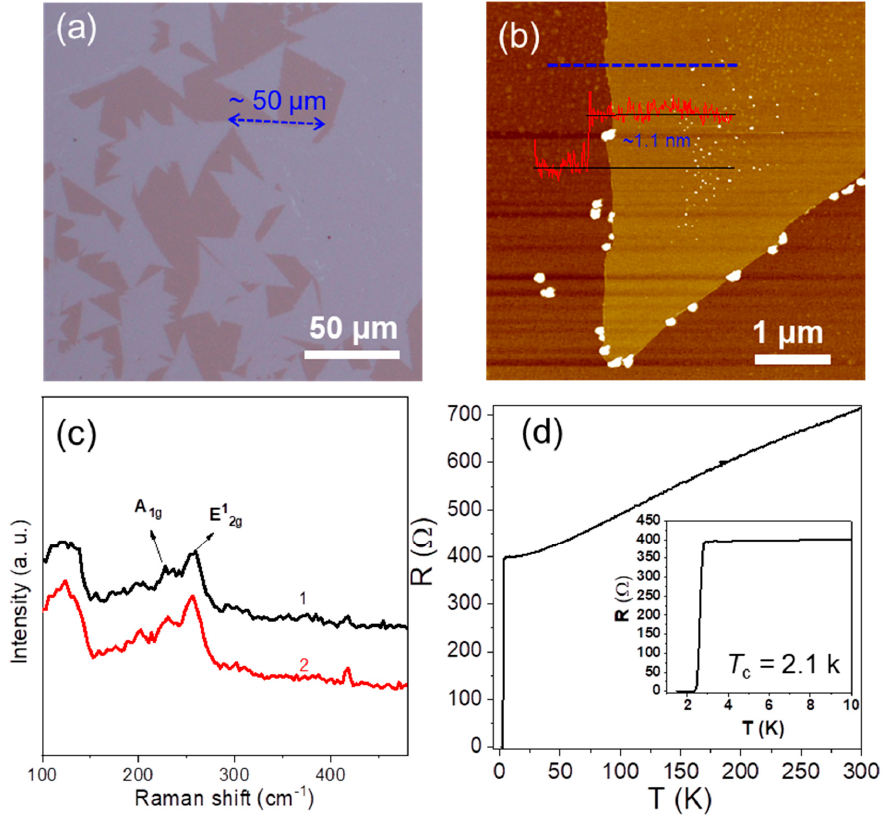
Figure 4. ( a ) Optical microscopic image; ( b ) AFM image and the corresponding height profile, the blue dotted line and red line are the measure site and corresponding height profiles, respectively; ( c ) Raman spectra (two different sites of the as-grown monolayer NbSe 2 were tested and are represented as black and red lines, respectively); and ( d ) temperature-dependent resistance of monolayer NbSe 2 crystal grown on sapphire.